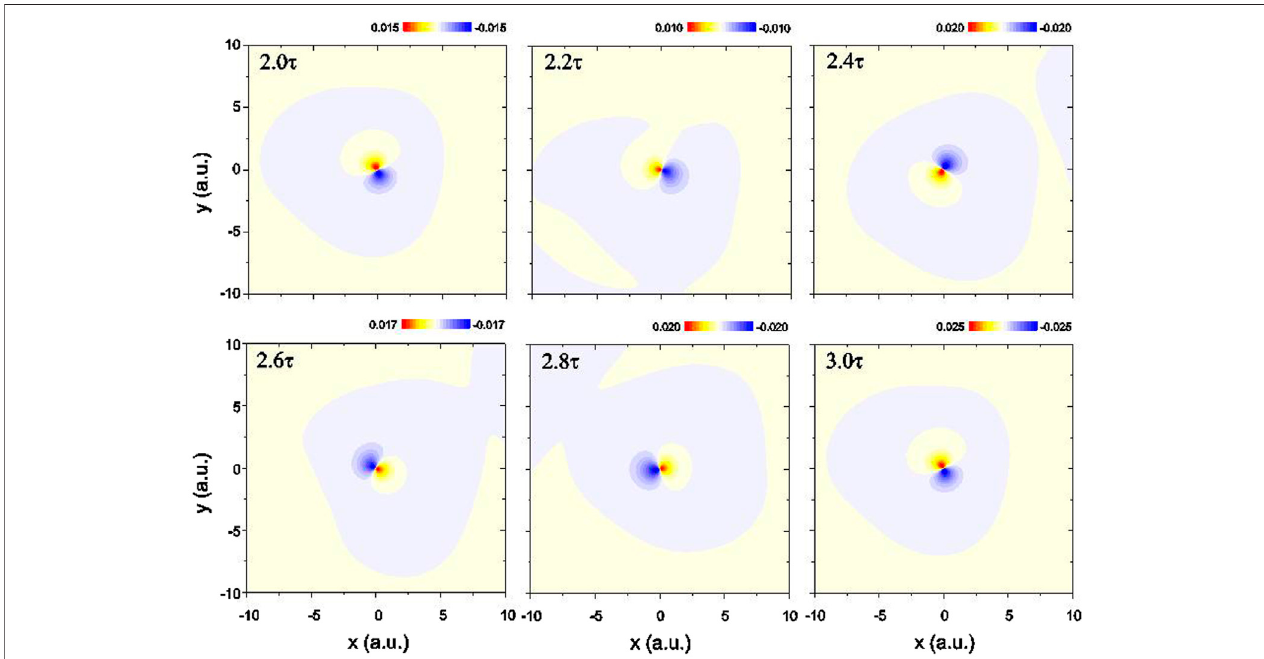
FIGURE 4 | Evolutions of the induced angular electron probability current density j ⊥ θ ( x , y , z (cid:1) 0 , t ) at different times t (unit of τ (cid:1) τ 1 (cid:1) 2 π / ω 1 ) for the molecule perpendicular to the laser polarization ( x , y ) plane, that is, around-axis R ⊥ E , by bichromatic counter-rotating ( ϵ (cid:1) − 1) circularly polarized laser pulses at wavelengths λ (cid:1) 70 nm ( ω (cid:1) 0 . 65 au) and λ (cid:1) 35 nm ( ω (cid:1) 1 . 3 au), intensities I (cid:1) 1 × 10 14 W/cm 2 (E (cid:1) 0.0534 au), duration T 1 1 2 2 ϕ (cid:1) 0. Units of induced angular electron currents are